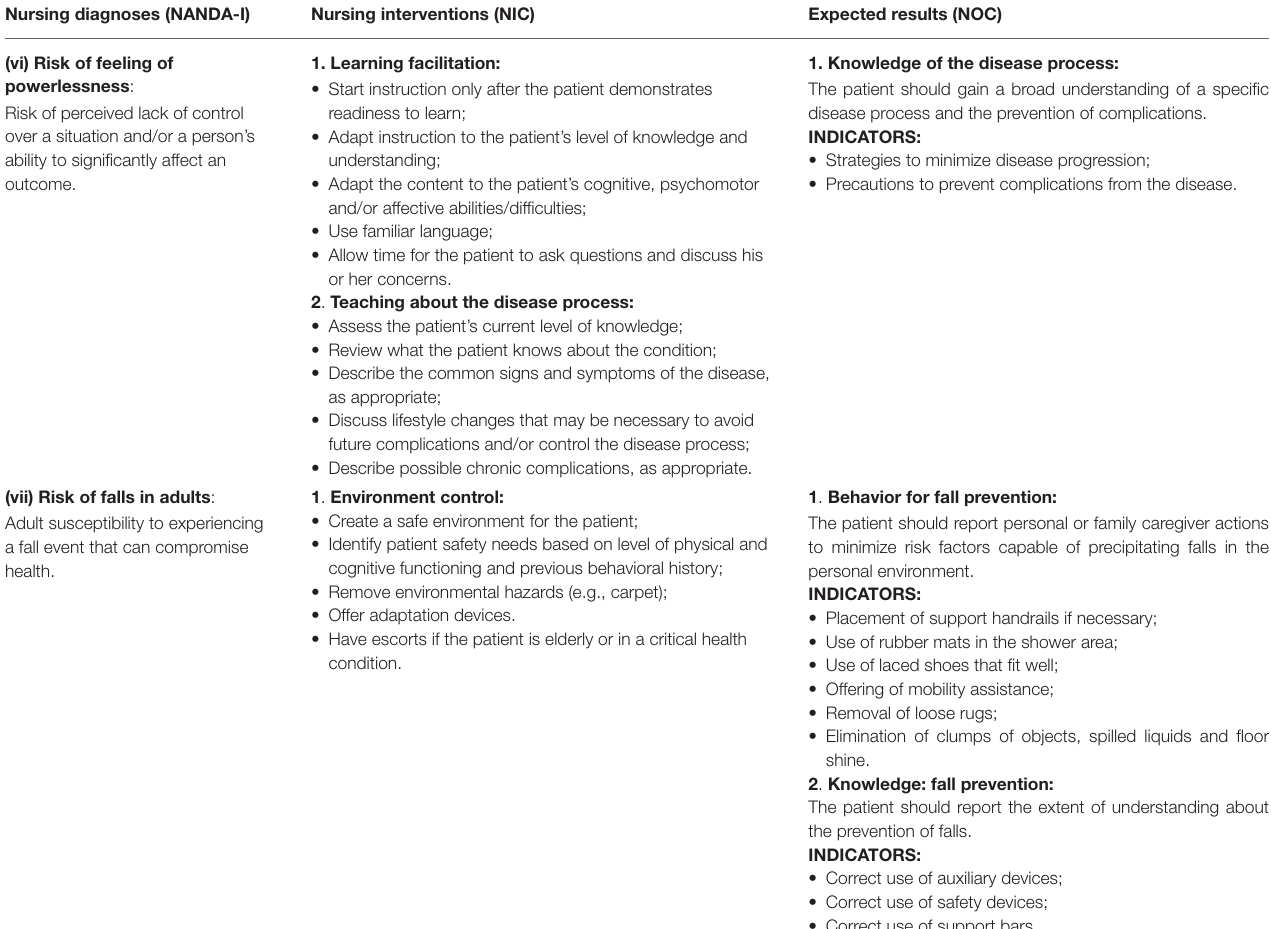
Nursing diagnoses (NANDA-I) Nursing interventions (NIC) Expected results